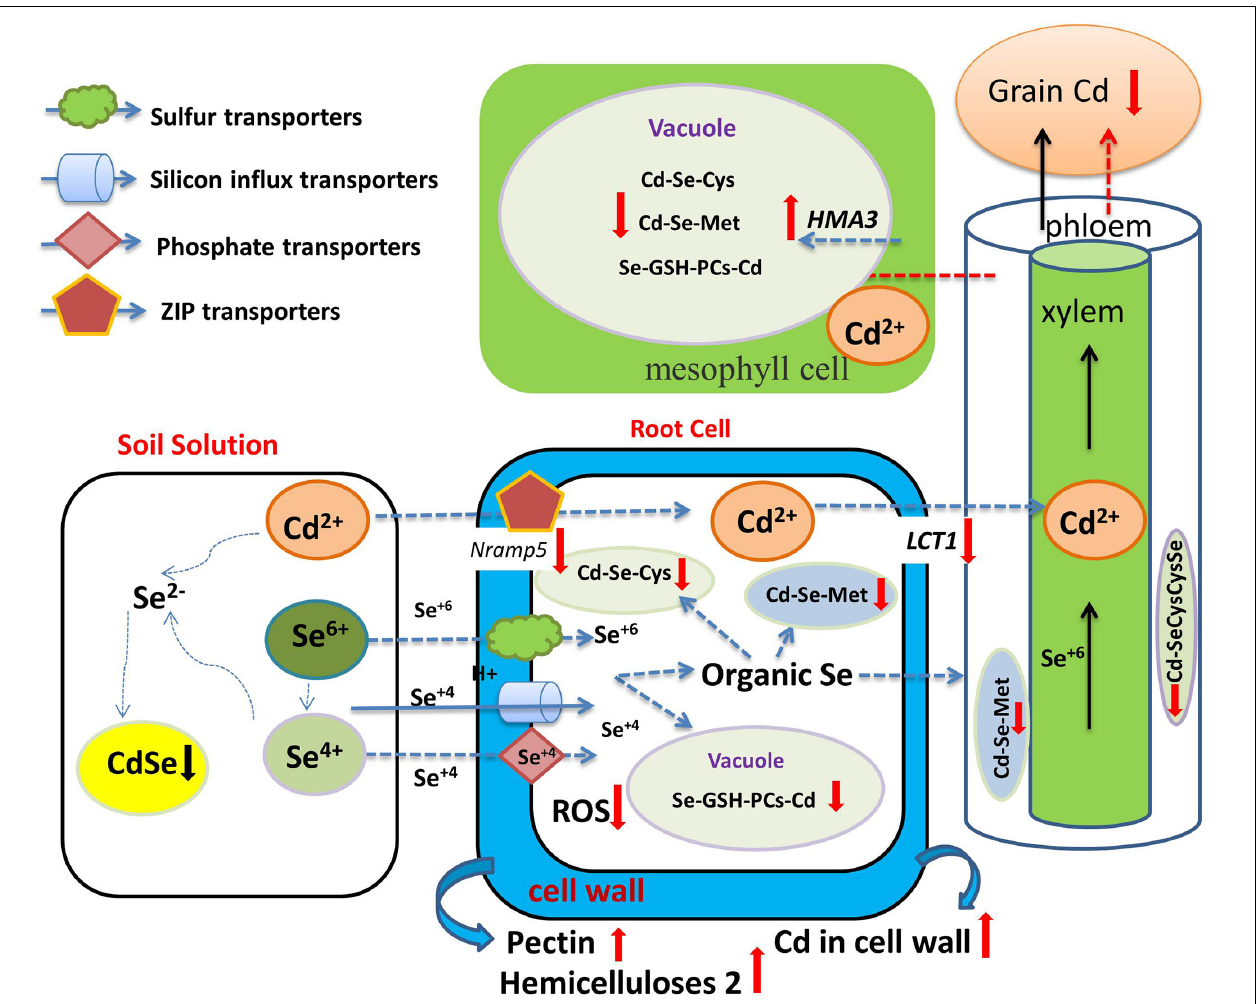
FIGURE 4 | Overview of the role of Se in regulating Cd bioavailability and accumulation. Se and Cd form CdSe complexes in soil unusable by plant roots (black down arrow). Se-Cd antagonism not only occurs in soil, but also manifests inside plant cells through the formation of Se- and Cd compounds, namely Cd-SeCysCysSe and Cd-SeMet (red down arrow), which are restricted in their upward, shoot-bound, Cd migration. Se reduces the expression of genes coding for Cd uptake and of transport-related genes (red down arrow), activates the expression of the tonoplast-resident transporter gene (red up arrow) and increases Cd accumulation in the plant cell wall (red up arrow). Se also increases GSH and PCs and reduces Cd transport from the root to the shoot and to the